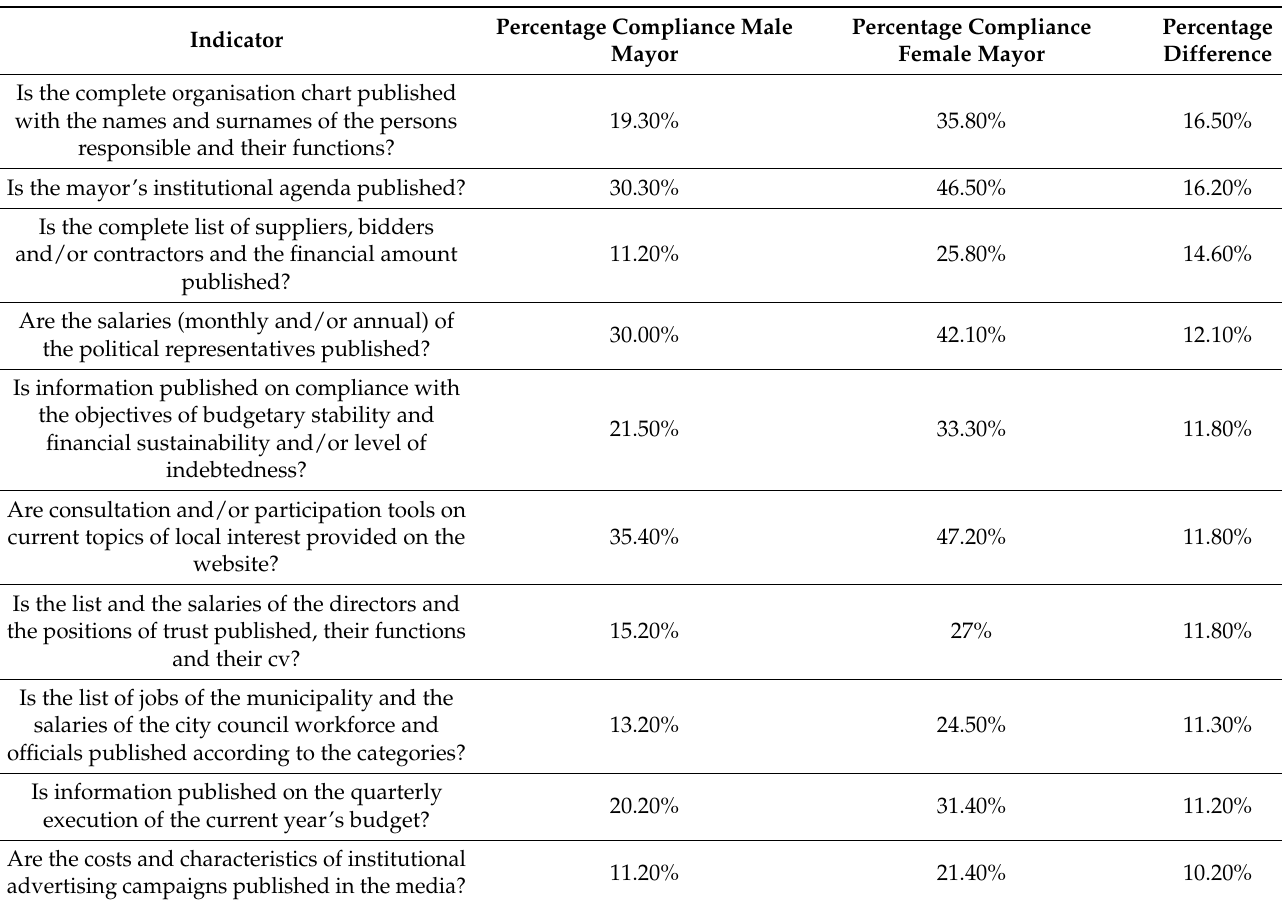
Table 6. Indicators with a greater percentage difference of compliance of indicators by women mayors compared to male